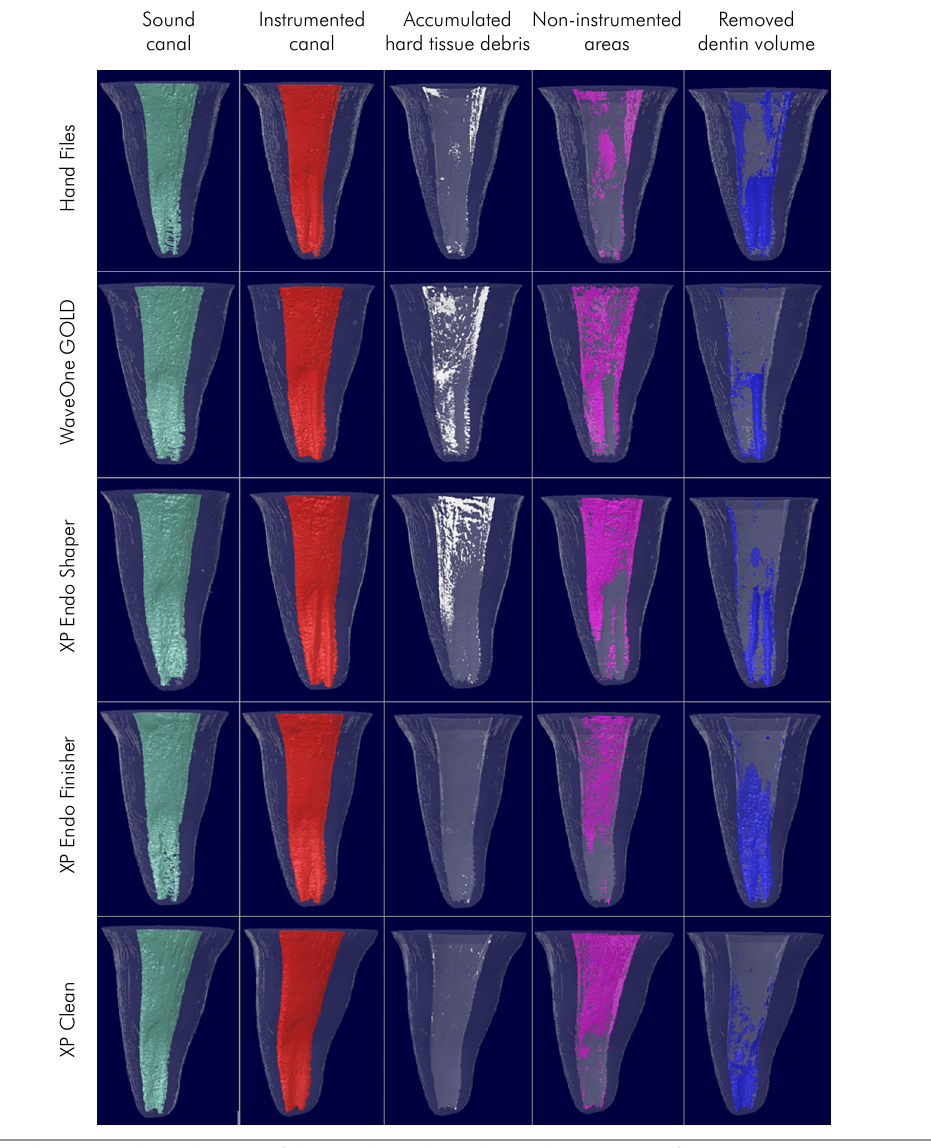
Figure 5. Three-dimensional renderings of the evaluated mechanical outcomes of a representative specimen from each instrumentation